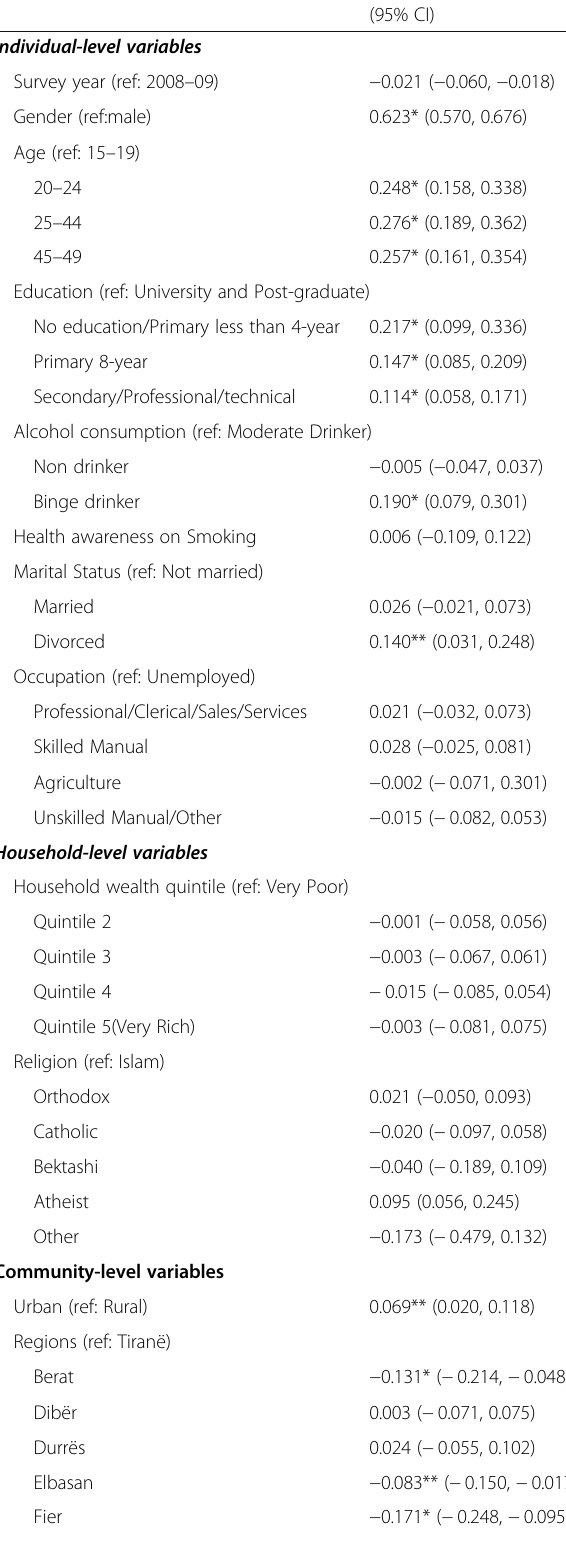
Table 4 Regression results for frequency of smoking ( N = 3277)